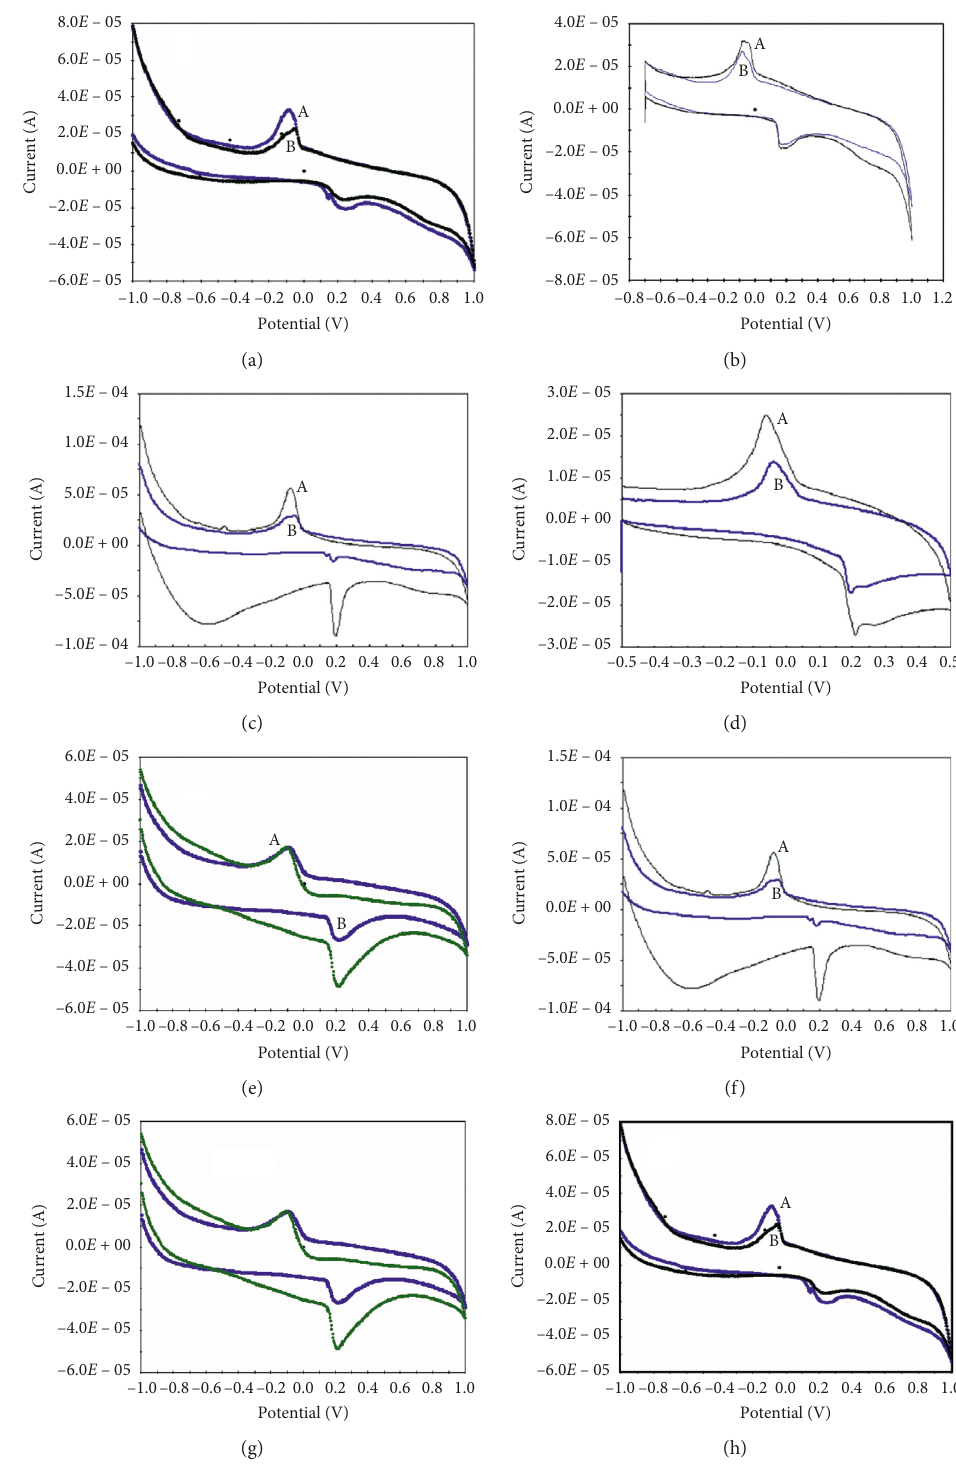
Figure 4: Cyclic voltammogram of heterocyclic Schiff base derivatives 1 – 8 (a–h) (30 μ molL − 1 ) in the absence (A) and presence (B) of 30 μ molL − 1 of DNA at 100mV/s scan rate in 5 mM Tris with pH